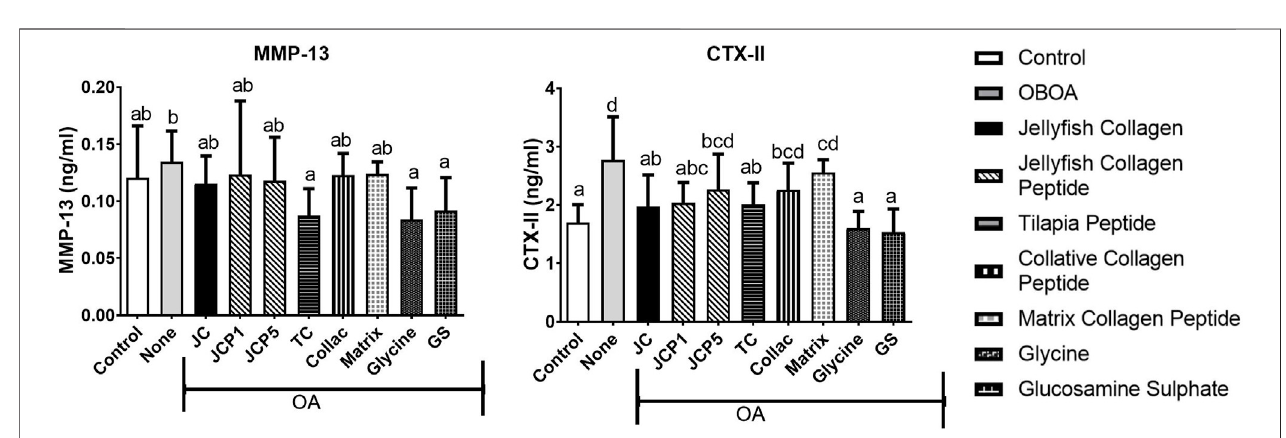
FIGURE 4 | Matrix metallopeptidase 13 (MMP-13) and C-telopeptide fragments of type II collagen (CTX-II) levels in rats ’ plasma.